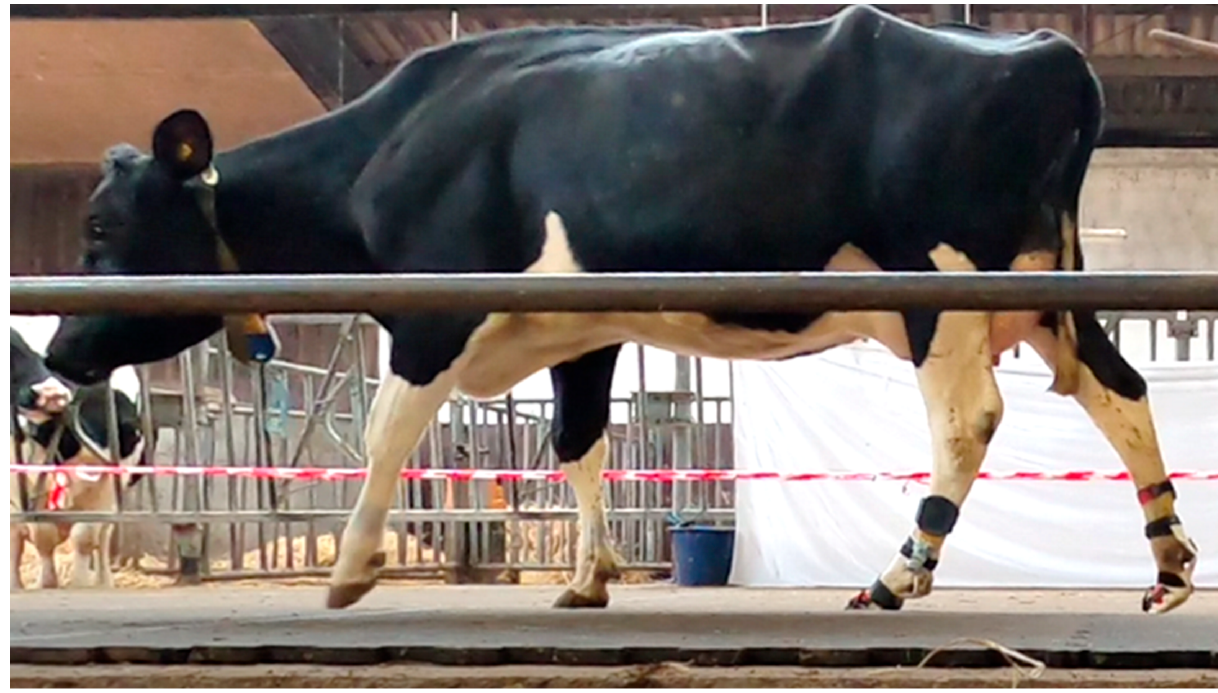
Figure 3. Cow walking across the walkway with rubber mats during the trial.